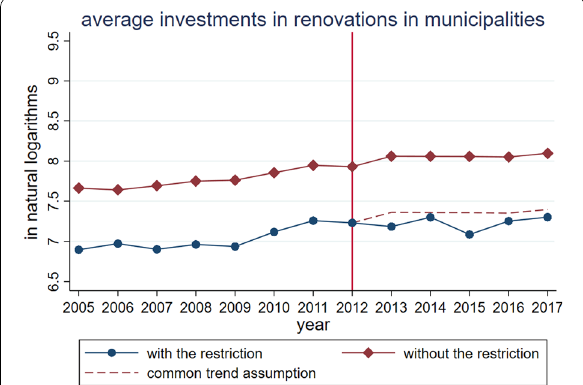
Fig. 5 Average investments in renovations in municipalities to which the second home restriction applies and for the remainder with